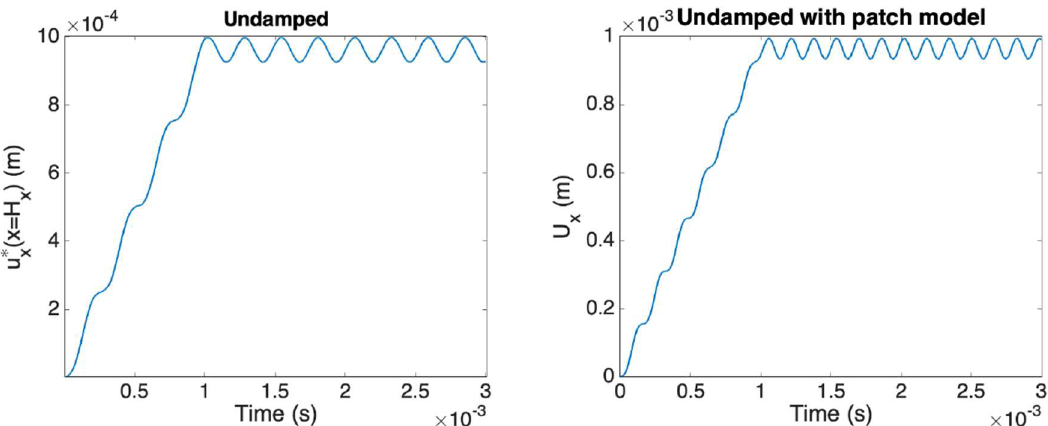
Fig. 17. Undamped explicit integrations: (left) the one related to the solution in the whole domain and already depicted in Figure 10 (right) and (right) the one related to the global-local integration.